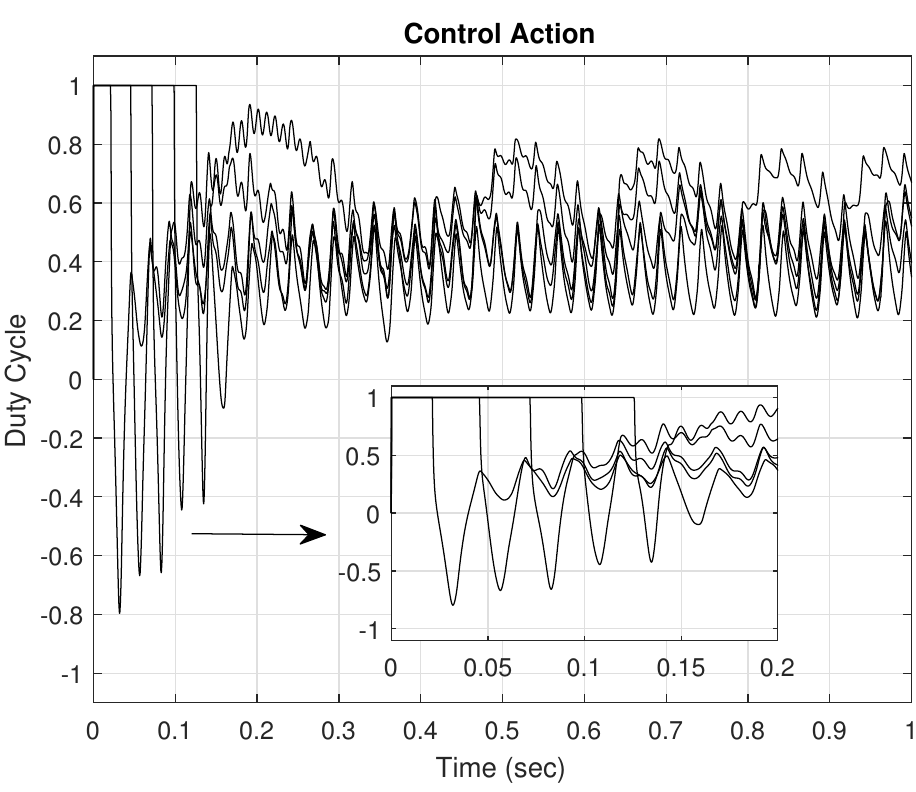
Figure 14. Control action with the modified